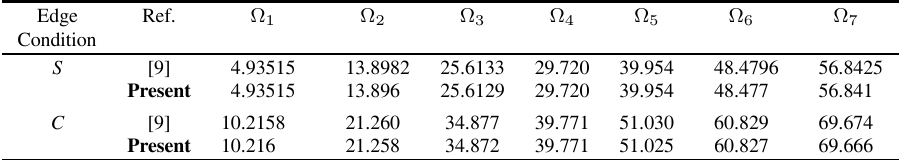
Table 2 Comparison of Ω for isotropic C and S - plates when α = β = 0 and e r =